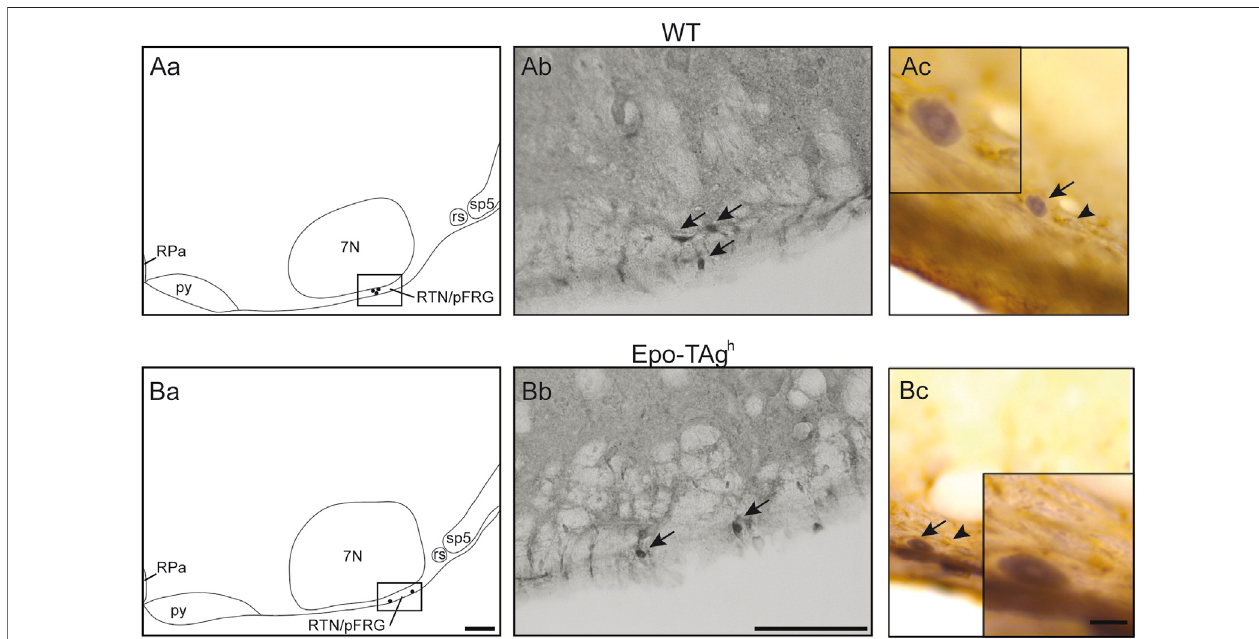
FIGURE 4 | Epo de fi ciency did not modify PHOX2B expression in RTN/pFRG and C-FOS positive cells of the RTN/pFRG did not express GFAP in WT and Epo- TAg h mice.DrawingsofrepresentativesectionfromtheventralmedullaoblongataillustratingthedistributionofPHOX2B-positivecells(blackpoints)intheretrotrapezoid nucleus/parafacial respiratory group of WT (Aa) and Epo-TAg h (Ba) mice. Scale Bar = 100 µm. The black box defines the photographed area in the right of drawings. Photomicrographs illustrating the immunolabelling for PHOX2B in the RTN/pFRG of WT (Ab) and Epo-TAg h (Bb) mice in normocapnia. Black arrows indicate PHOX2B-positivecells.Scalebar:100 µm.PhotomicrographsintheRTN/pFRGofasectiondually immunolabelledforc-FOSand GFAPinWT (Ac) andEpo-TAg h (Bc) mice in hypercapnia. Black arrows showed c-FOS positive neurons nuclei and black arrowheads showed GFAP-positive astrocytic extensions. Note that GFAP-cells werenotc-FOSpositive.Theinsertsshowanenlargementoftheareaofinterest.Scalebar=10 µm.Abbreviations:7N,facialnucleus;py,pyramidaltract;rs,rubrospinal tract; sp5, spinal trigeminal tract; RPa, raphe pallidus nucleus; RTN/pFRG, retrotrapezoid/parafacial respiratory